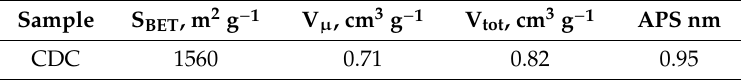
Table 1. Porosity characteristics of CDC particles.